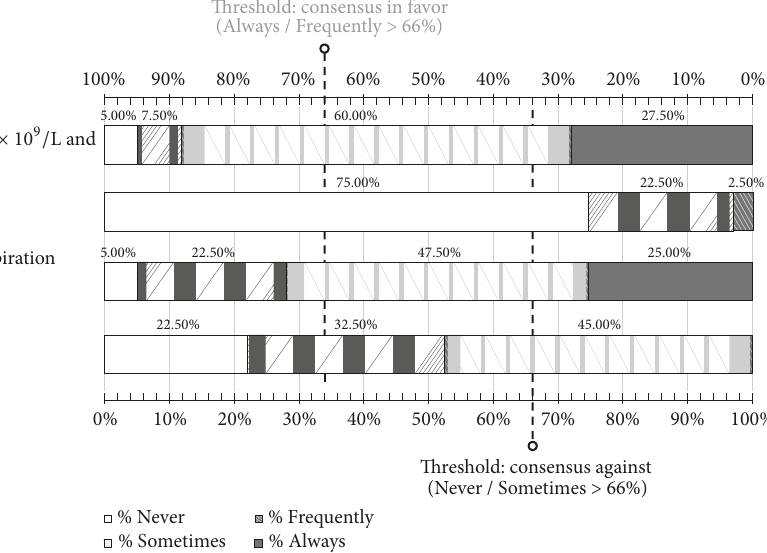
Figure 1: Results obtained in the section of the questionnaire regarding diagnosis of ITP. Distribution of the percentages of responses.